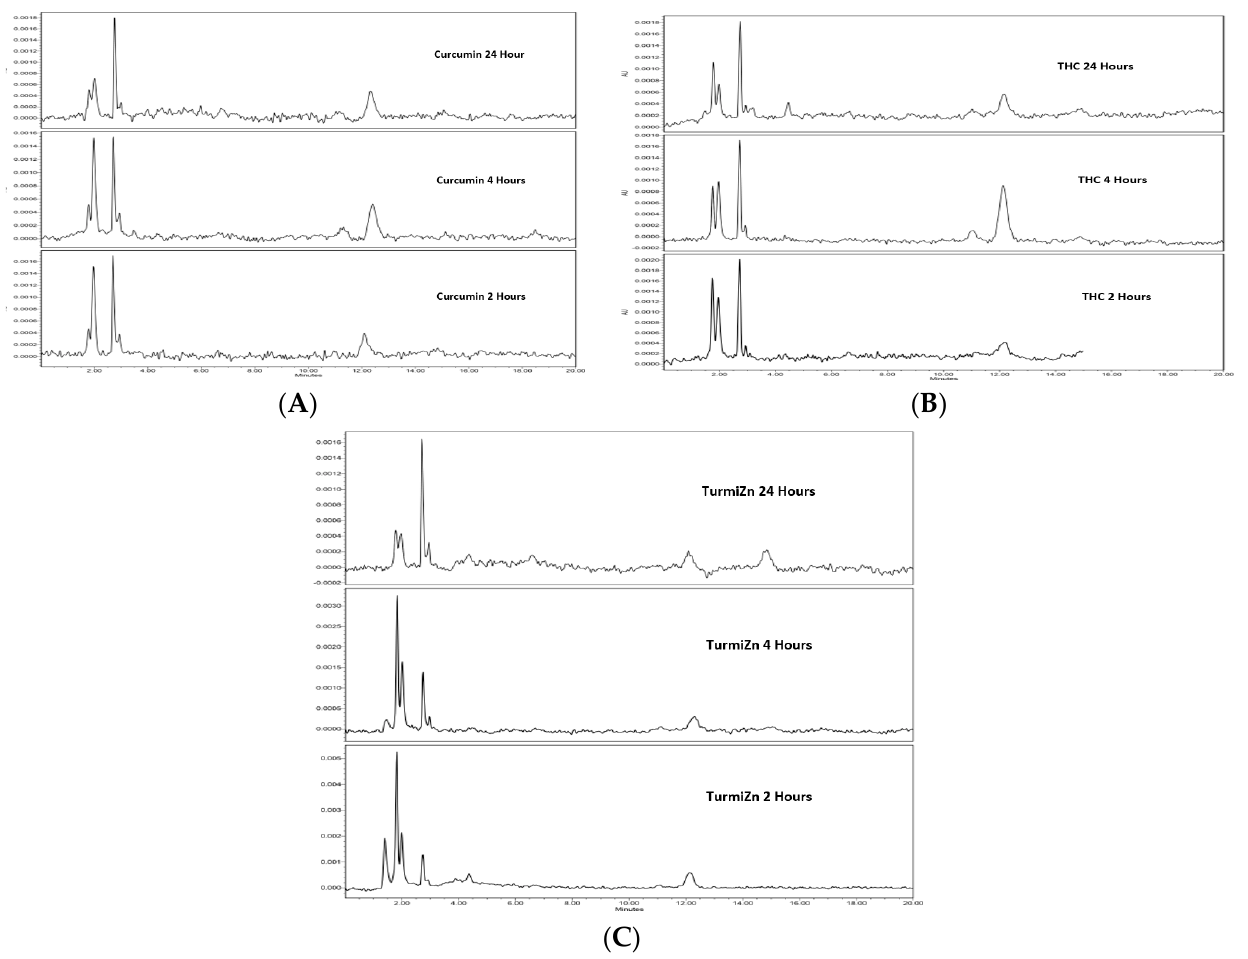
Figure 2. ( A ): HPLC chromatograms of curcuminoids in chicken plasma 2, 4, and 24 h post oral administration at 425 nm. ( B ): THC in chicken plasma at 2, 4, and 24 h post oral administration at 425 nm. ( C ): TurmiZn (THC-Zn-Curcumin) in chicken plasma at 2, 4, and 24 h post oral administration at 425